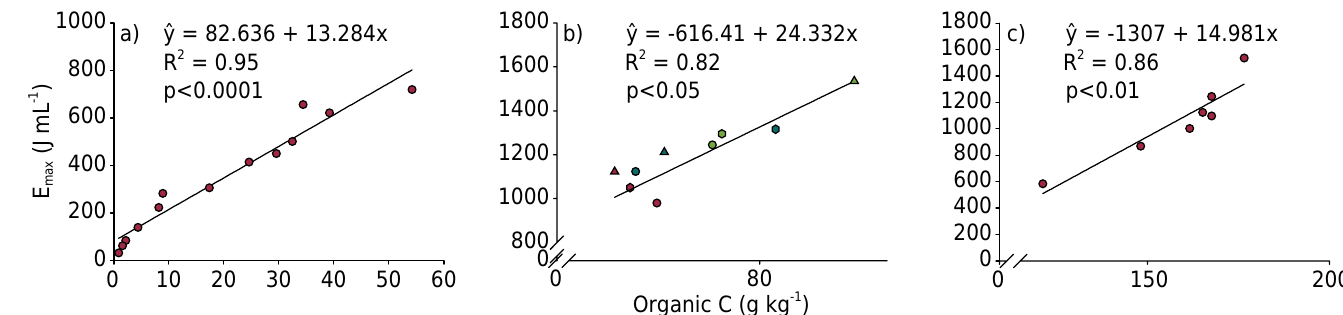
Figure 5. Linear regressions between the organic C content and dispersion energy levels in a) OX, b) FH, and c)